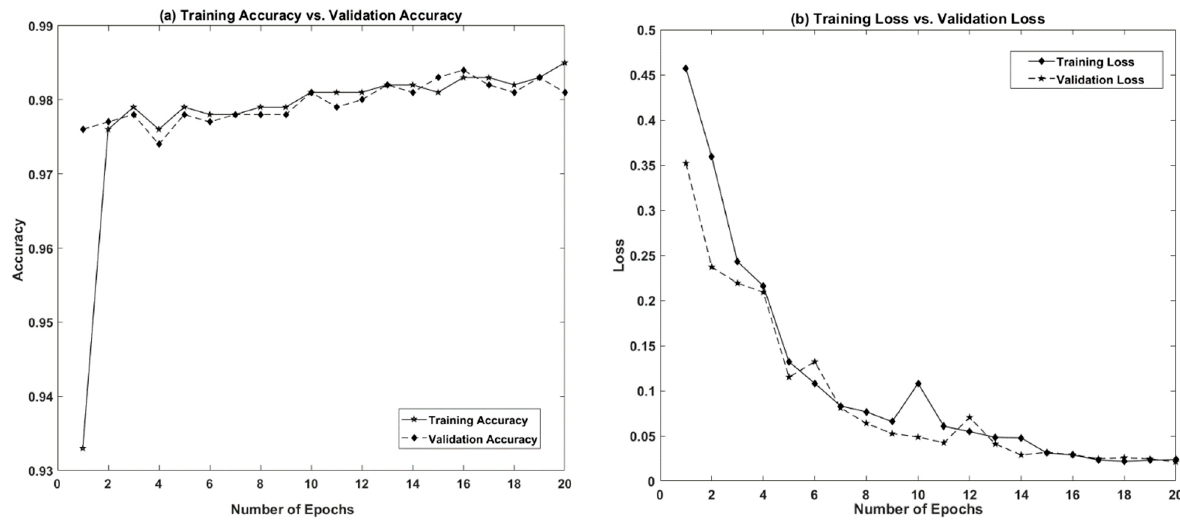
Figure 8. Training and validation of the proposed model (2.8 k Dataset). ( a ) Accuracy graph. ( b ) Loss graph.